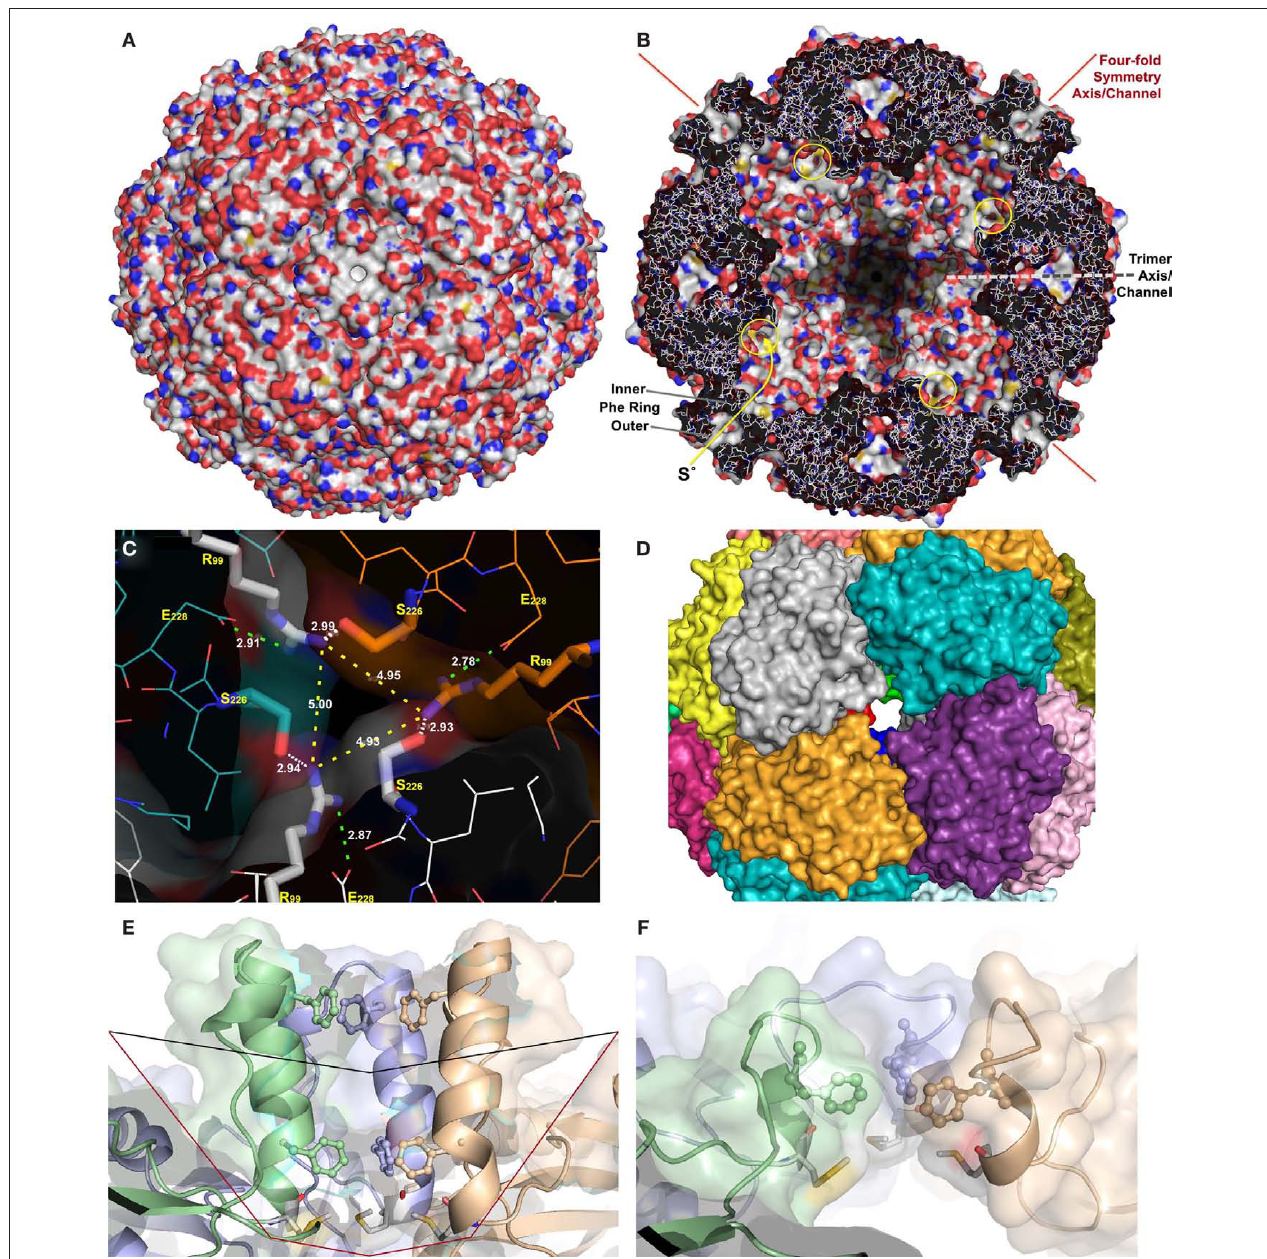
FiguRe 2 | X-ray crystallography and modeling of the SOR and its pores. (A) of the neighboring and for the putative hydrogen bond to the O γ of the S 226 Surface representation of the holoenzyme centered at the chimney-like structure subunit (white dashes). (D) Subunit representation of the large deletion mutant at at the fourfold symmetry axis. (B) Representation of the protein structure and the the fourfold symmetry axis DelL ( Figure 1 ) modeled at the SwissModel server inner surface of the holoenzyme sliced at the center of the fourfold symmetry (Arnold et al., 2006). (e) Side view of the channel at the fourfold symmetry axis axes; the position of the inner and outer phenylalanine rings are indicated, also with outer (F ) and inner phenylalanine rings (F ; from top, showing three out 141 133 the active site pores (yellow circles), and the approximate position of the trimer of four subunits; wild type) and the methionine ring at its base (M ); black line, 130 symmetry axis, which is tilted out of plane. (C) Channel at the threefold approximate position of small deletion (DelK); red line, large deletion of entire symmetry axis formed by R chimney (DelL). (F) Model of the same three subunits as in panel E of the short and S ; distances are given between the N η 99 226 DelK deletion, modeled at the Phyre server (Kelley and Sternberg, atoms of the arginines (yellow dashes), for the salt bridges to E (green dashes), 228